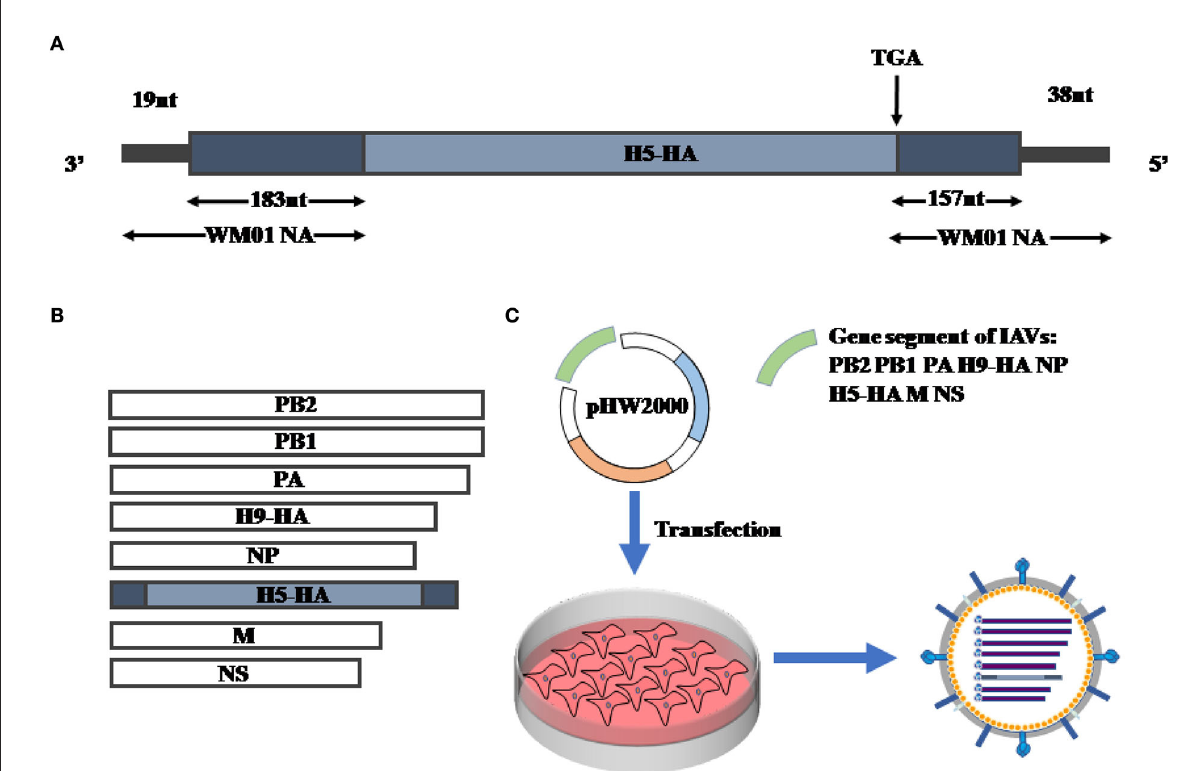
FIGURE2 Generation of replication-deficient recombinant WM01ma-HA (H5). (A) Schematic representation of chimeric HA gene segment. The open reading frame (ORF) of HA (HN01ma, H5N1) is flanked by the NA segment-specific packaging sequences derived from WM01ma (H9N2). (B) The eight segments for WM01ma-HA (H5) recombinant viruses. (C) Rescue of recombinant WM01ma-HA (H5) influenza virus by the reverse genetic